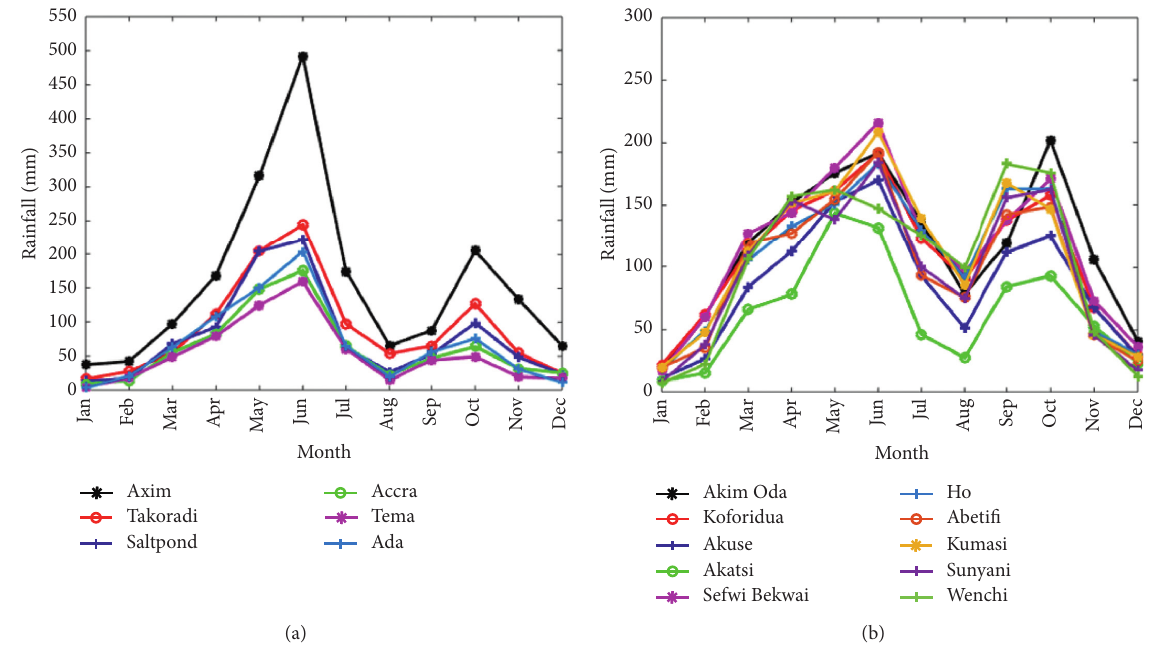
Figure 6: MMR (1981–2010). Bimodal rainfall pattern within Southern Ghana: six and eleven stations along the coast (a) and over the middle sector (b), respectively.